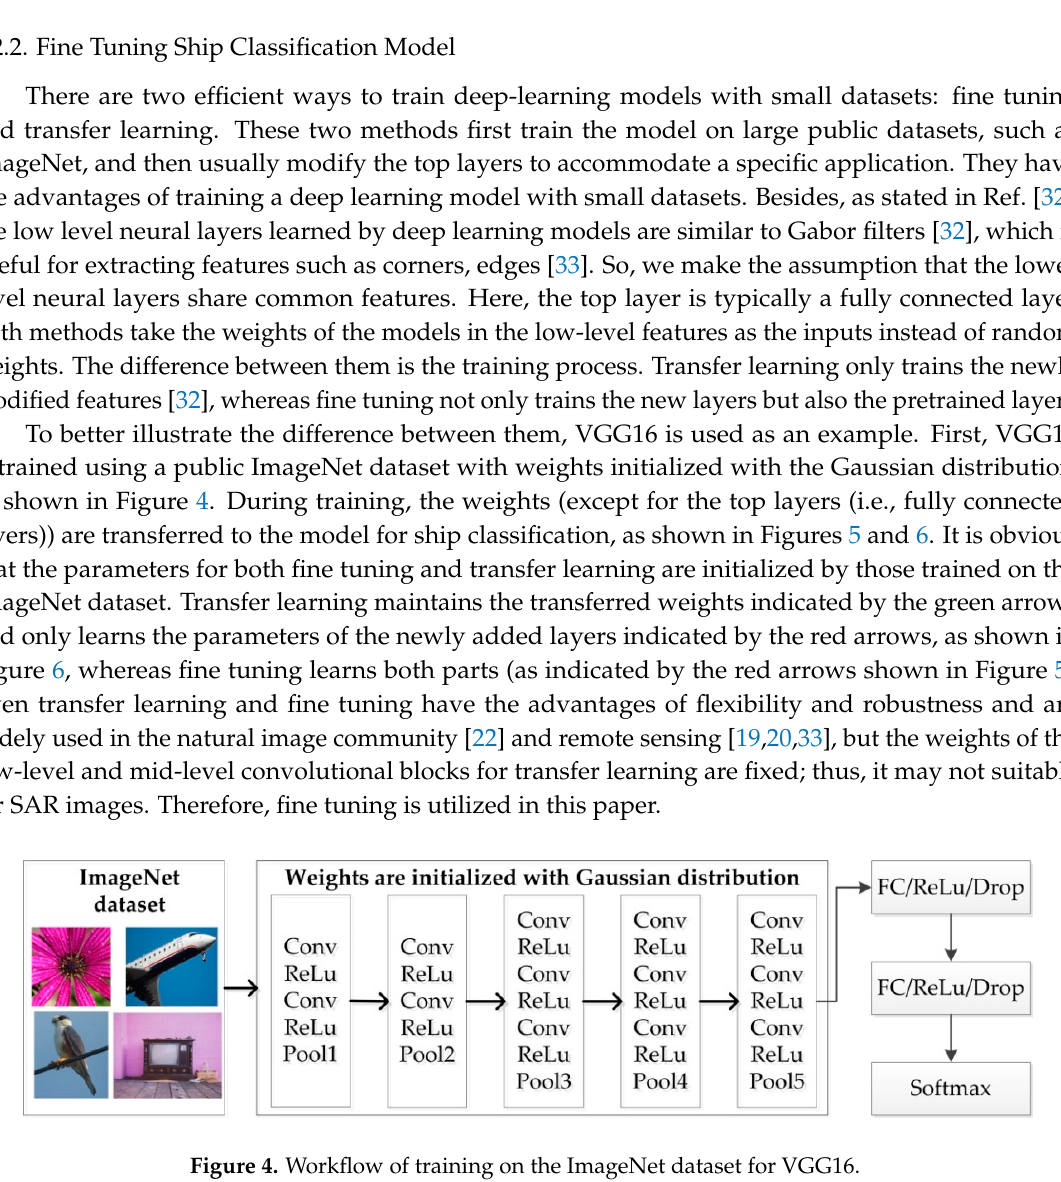
Figure 5. Workflow of training using fine tuning on the ship dataset for ship classification based on VGG16. The red arrows indicate the weights involving these layers will be learned.